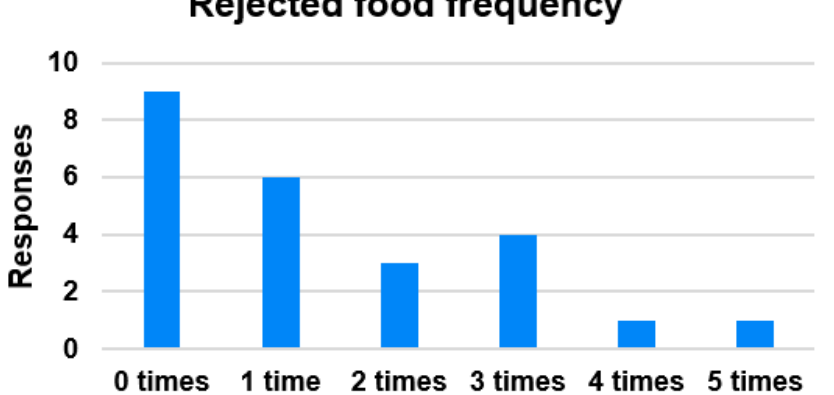
Figure 5. How frequently children are unsatisfied with a lunch.